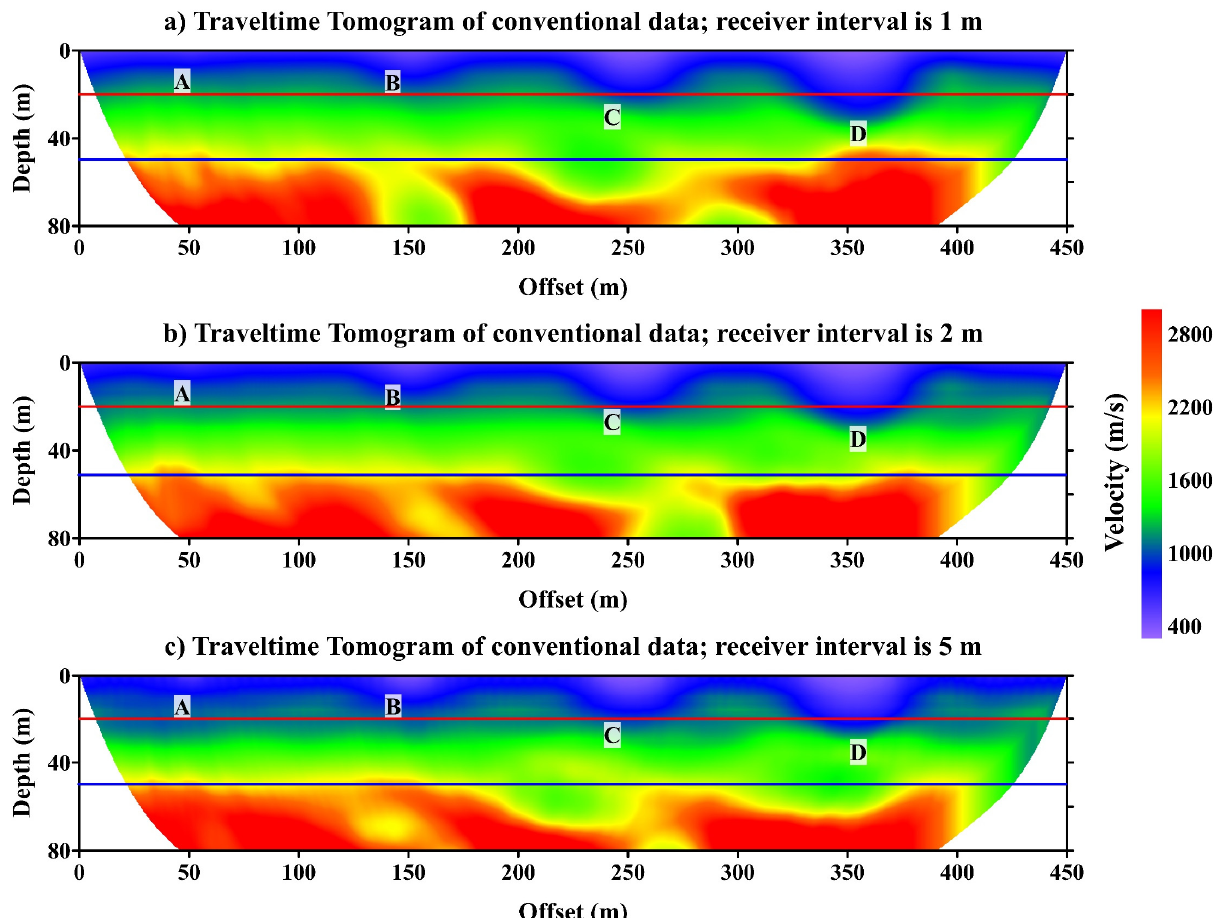
Figure 8. The traveltime tomograms of the conventional synthetic example. A, B, C, and D represent the four local anomalies added to the velocity model. The red- and blue-horizontal lines represent the refractors between the first-second and second-third layers, respectively. ( a – c ) are the 1 m, 2 m, and 5 m source and receiver intervals, respectively.